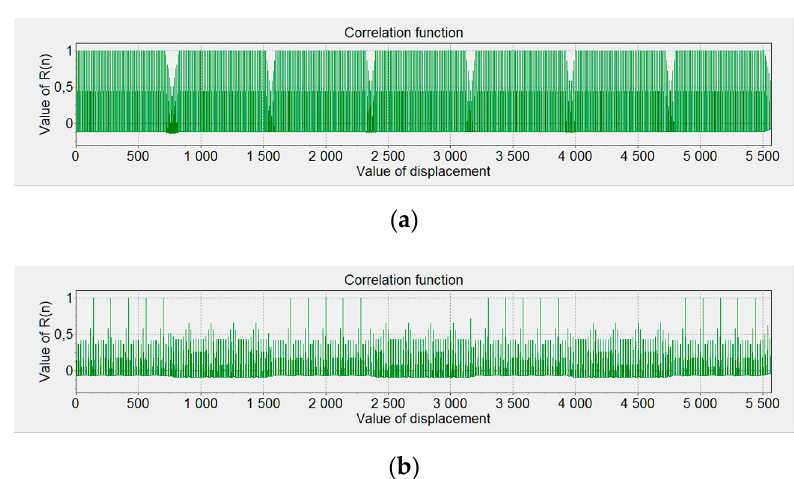
Figure 9. A selection window for edge smoothing modes.